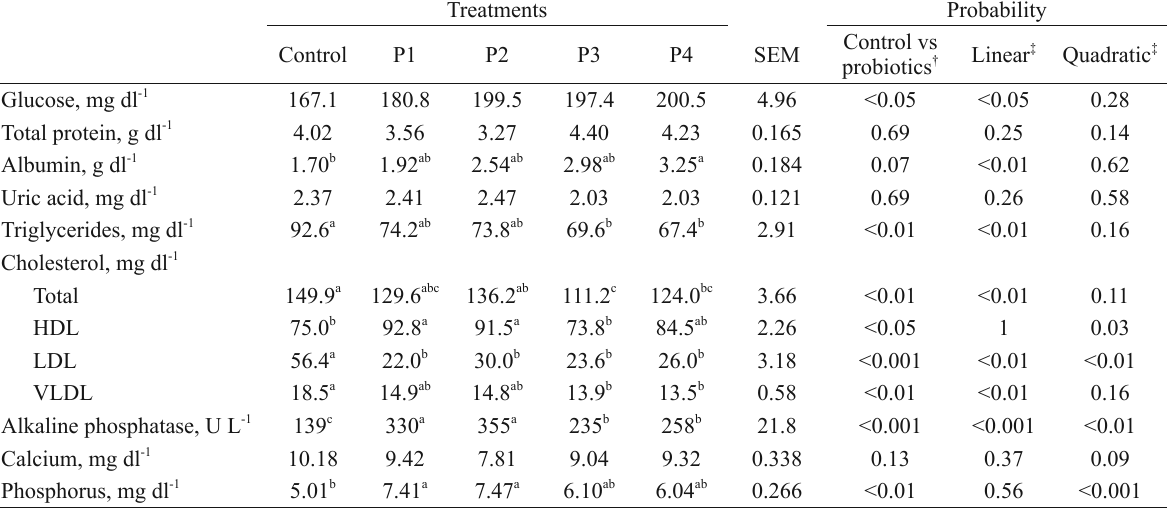
Blood plasma constituents of 6-week old broilers fed diets containing either no probiotics (control) or 0.005%, 0.01%, 0.015% and 0.02% of probiotics (P1, P2, P3 and P4, respectively). All data were obtained from four birds per treatment. Treatments Probability Control